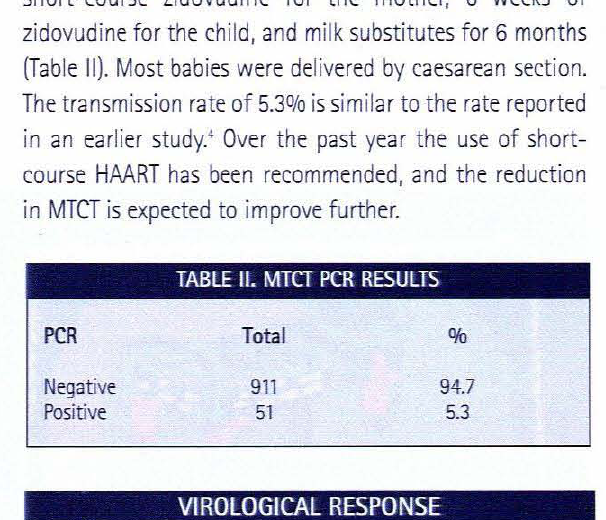
TABLE Ill. CD4 COUNT DISTRIBUTION AT ENROLMENT ON